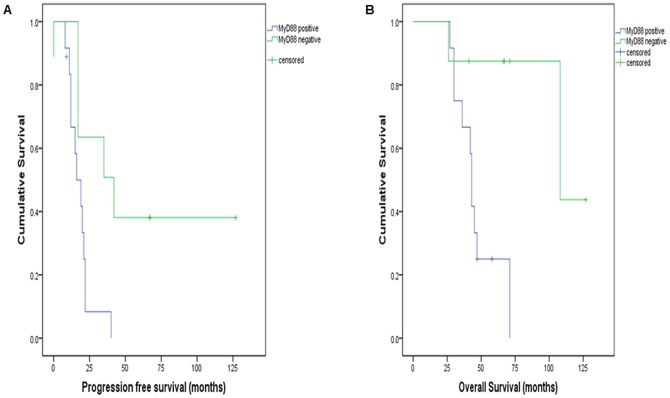
MyD88 expression and survival (Kaplan-Meier curves: median survival time shown in months).MyD88 positive tumours (n = 12) had significantly reduced progression-free survival (A) and overall survival (B) (p = 0.018 and p = 0.008, respectively).